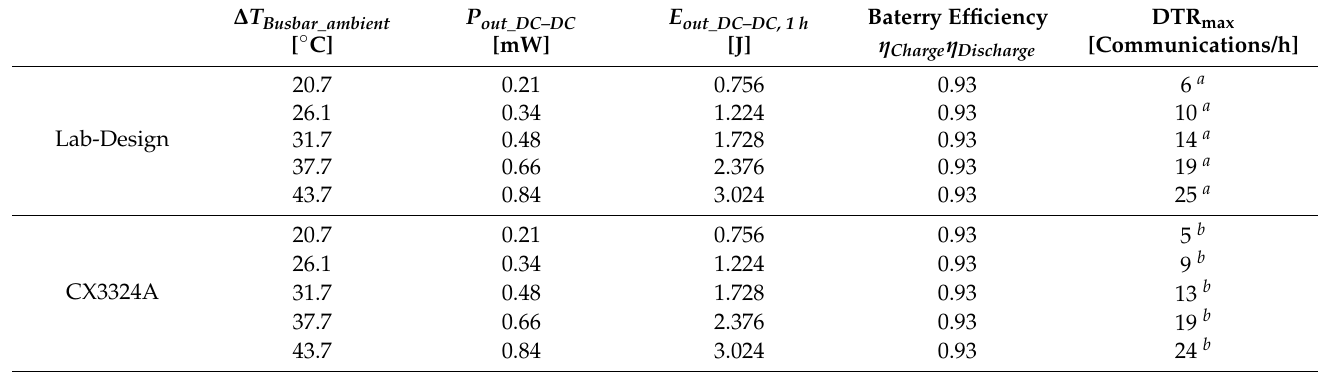
Table 5. Determination of the maximum data transfer rate for the IoT